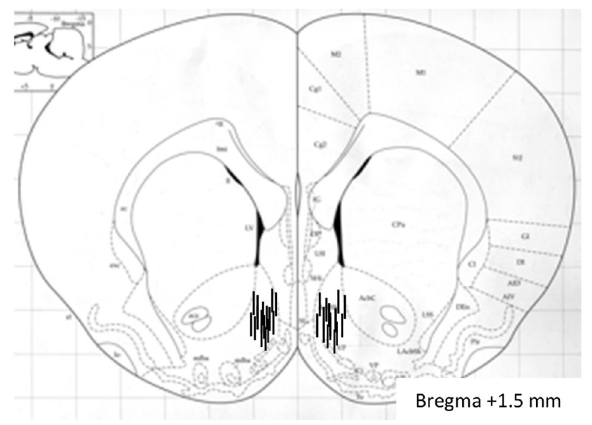
Figure 1. A coronal mouse brain section showing probe placements (illustrated by vertical lines) in the nucleus of mice used in the present study. The number given indicates millimeters anterior (+) from